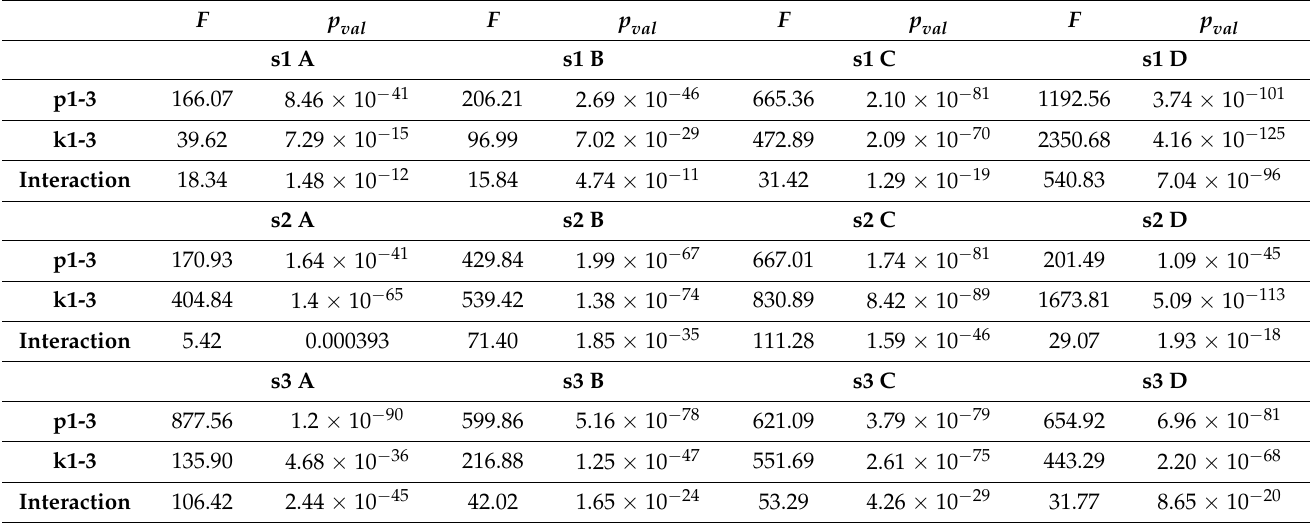
Table 4. The average values and the statistical data on the average amplitude of the EMG signal values 𝑀𝑉𝐶 𝑀𝐴𝑋 ) for the individual propulsion cycles; 𝑥̅ — the arithmetic mean, 𝜎 — the standard de- Table 3. The statistical data of the analysis of variance (ANOVA); F —F test value, p val —test probabil- viation of the arithmetic mean; the muscle markings: Deltoid muscle anterior (A) and posterior (B), ity of ANOVA analysis, Deltoid muscle anterior (A) and posterior (B), Triceps brachii (C), Extensor Triceps brachii (C), Extensor carpi radialis longus (D); markings of experiment series: s1, s2 and s3; carpi radialis longus (D); markings of the angles of erection of the wheelchair: k1 = 0 ◦ , k2 = 1.5 ◦ and markings of the propulsion system gear ratios: p1 = 1.96, p2 = 1 and p3 = 0.51. k1 = 5.4 ◦ ; markings of experiment series: s1, s2 and s3; markings of the propulsion system gear ratios: s1 A s1 B s1 C s1 D p1 = 1.96, p2 = 1 and p3 = 0.51.